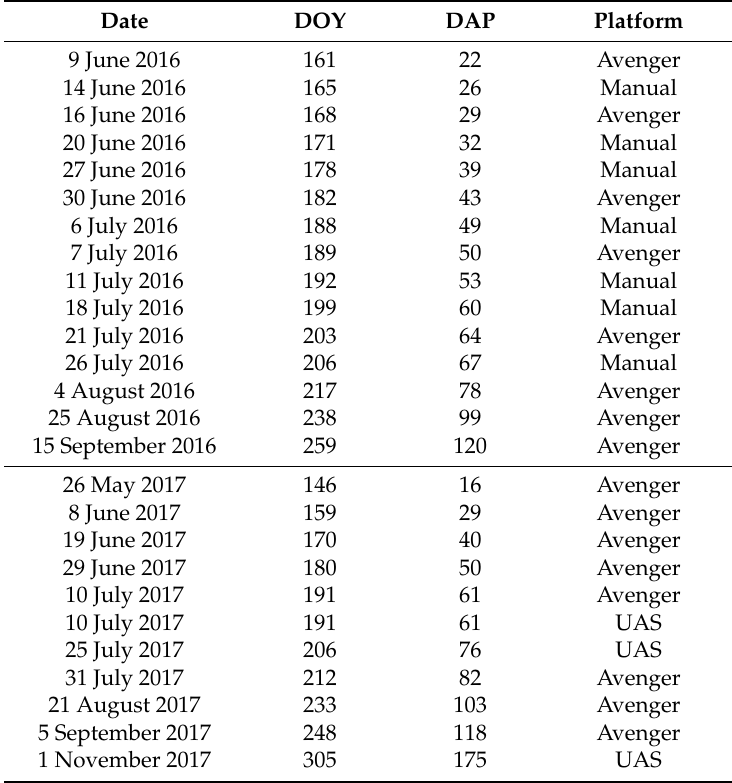
Table 2. List of collection dates, corresponding day or year (DOY) and calculated days after planting (DAP) for each platform in 2016 and